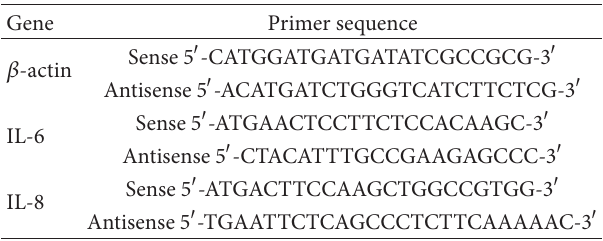
Table 1: Primer sequences for real-time PCR for 𝛽 -actin, IL-6, and IL-8.